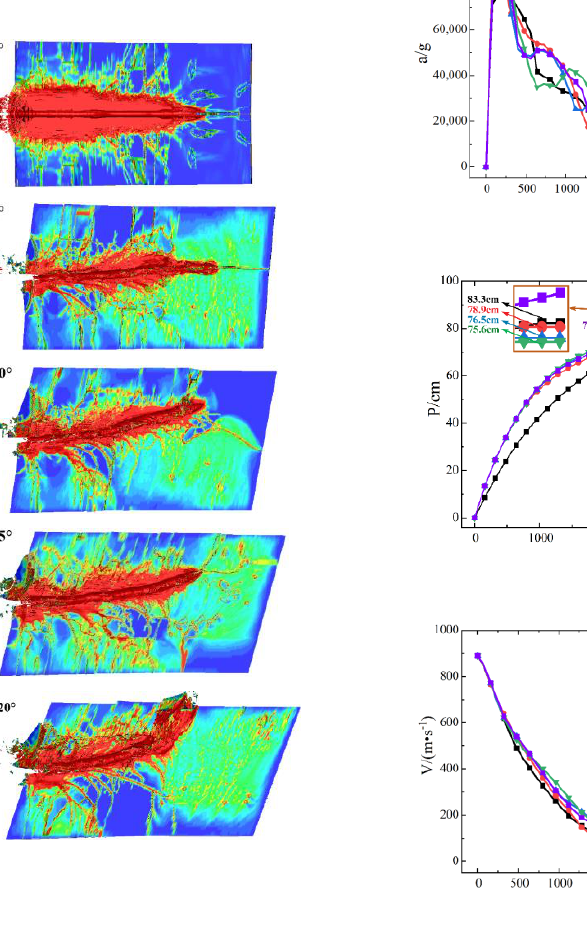
Figure 13. Results of projectile oblique penetration into red sandstone target: ( a ) penetration acceleration curve in X direction; ( b ) penetration acceleration curve in Y direction; ( c ) penetration depth-variation curve in X direction; ( d ) penetration depth-variation curve in Y direction; ( e ) penetra- tion velocity-variation curve in X direction; ( f ) penetration velocity-variation curve in Y